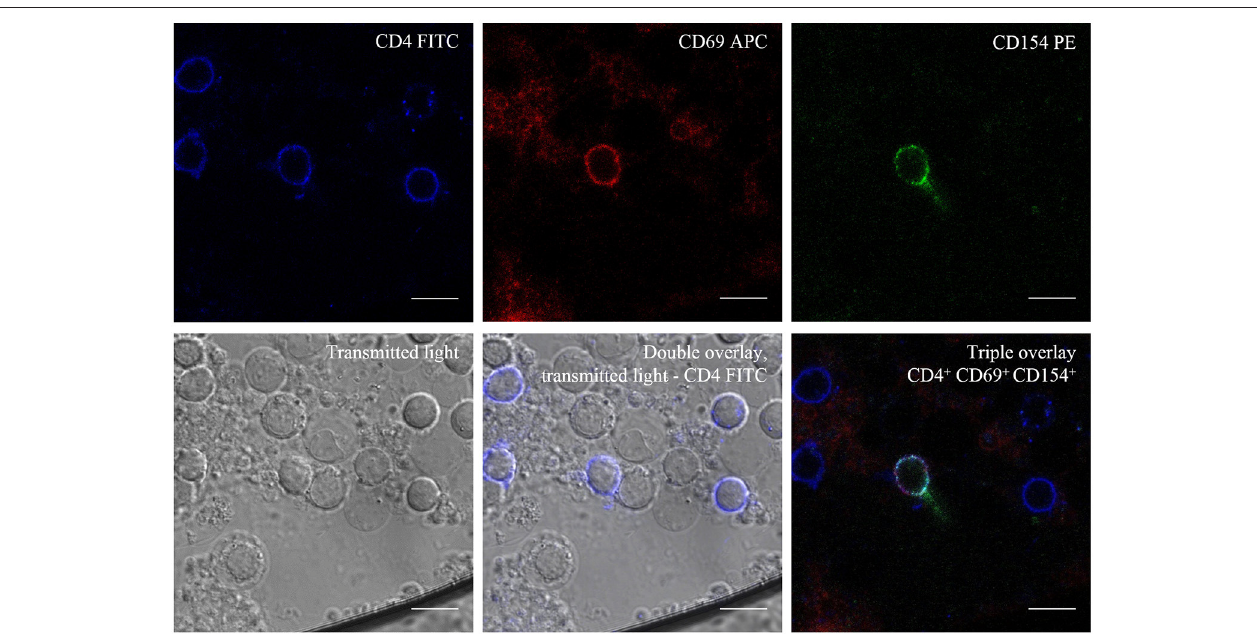
FIGURE 3 | Transmitted Light—Differential Interference Contrast (DIC) and Fluorescence Microscopy of C. albicans -reactive T cells. CD4 + T cells after antigen stimulation with C. albicans lysate and show triple positivity, CD4 + /CD69 + /CD154 + after stimulation. Scale bar = 10 µ m.